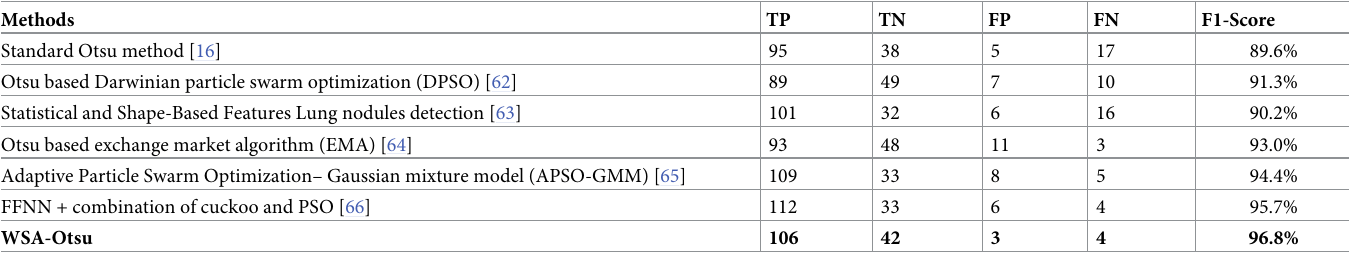
Table 2. The comparison of WSA-Otsu with counterpart